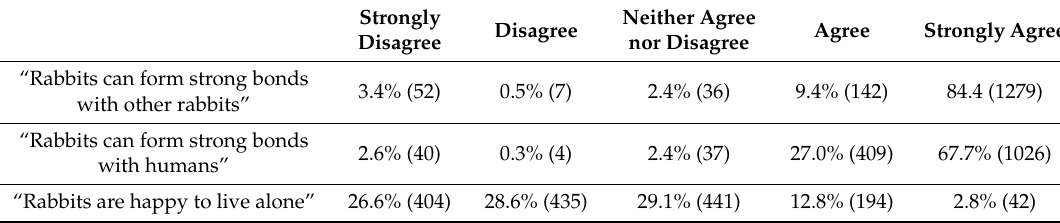
Table 3. Answers provided to “Please choose how much you agree or disagree with the following statements: Rabbits can form strong bonds with other rabbits; Rabbits can form strong bonds with humans; Rabbits are happy to live alone” n = 1516.